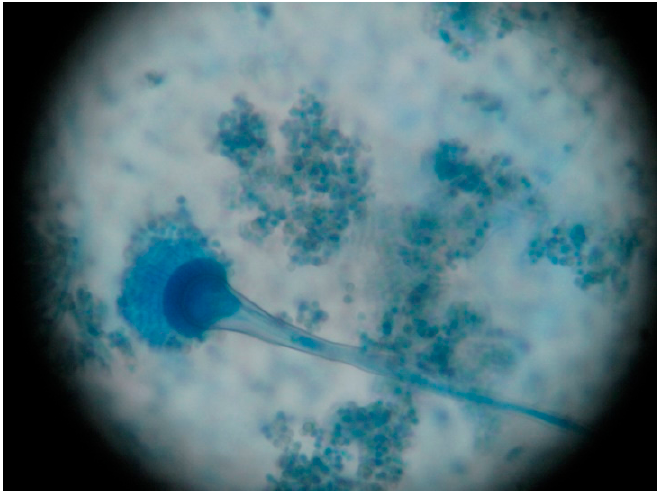
Figure 5. Aspergillus fumigatus , wet mount with methylene blue (cellophane tape mount), 400×, Optic microscope (Karl Zeiss, Jena, Germany).